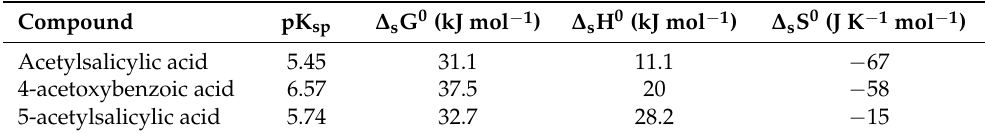
Table 4. Gibbs free energies, enthalpies and entropies of solution of acetylsalicylic acid, 4-